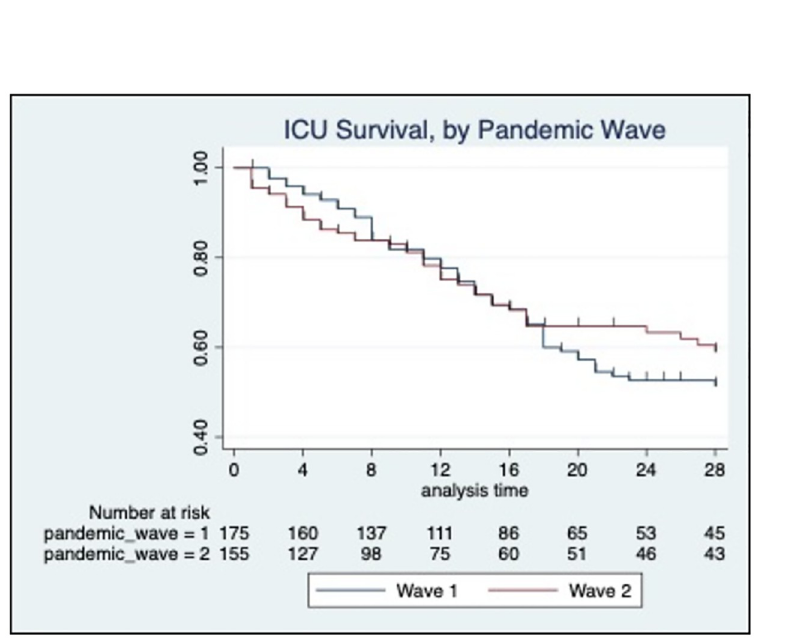
Fig 3. Kaplan-Meier survival demonstrates the proportion of ICU survival by UK pandemic wave. Single hash mark denotes an ICU discharge (alive). Log-rank p = 0.630 demonstrating no statistical difference in survival between the pandemic